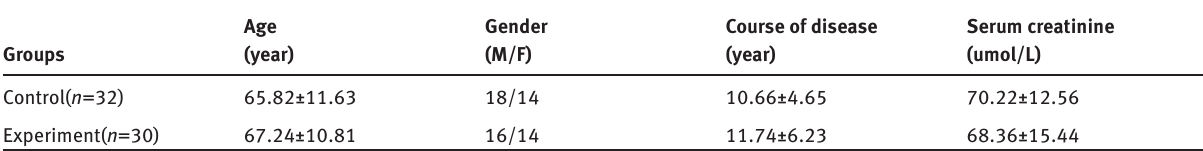
Table 1: General characteristics of the two groups